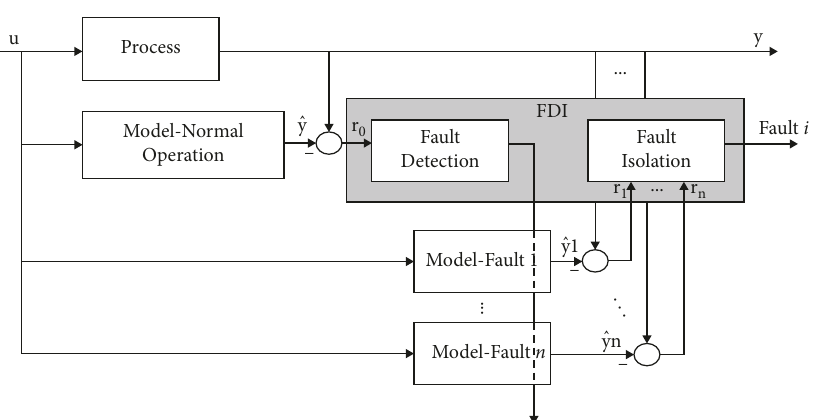
Figure 3: Fault detection and isolation (FDI) method from